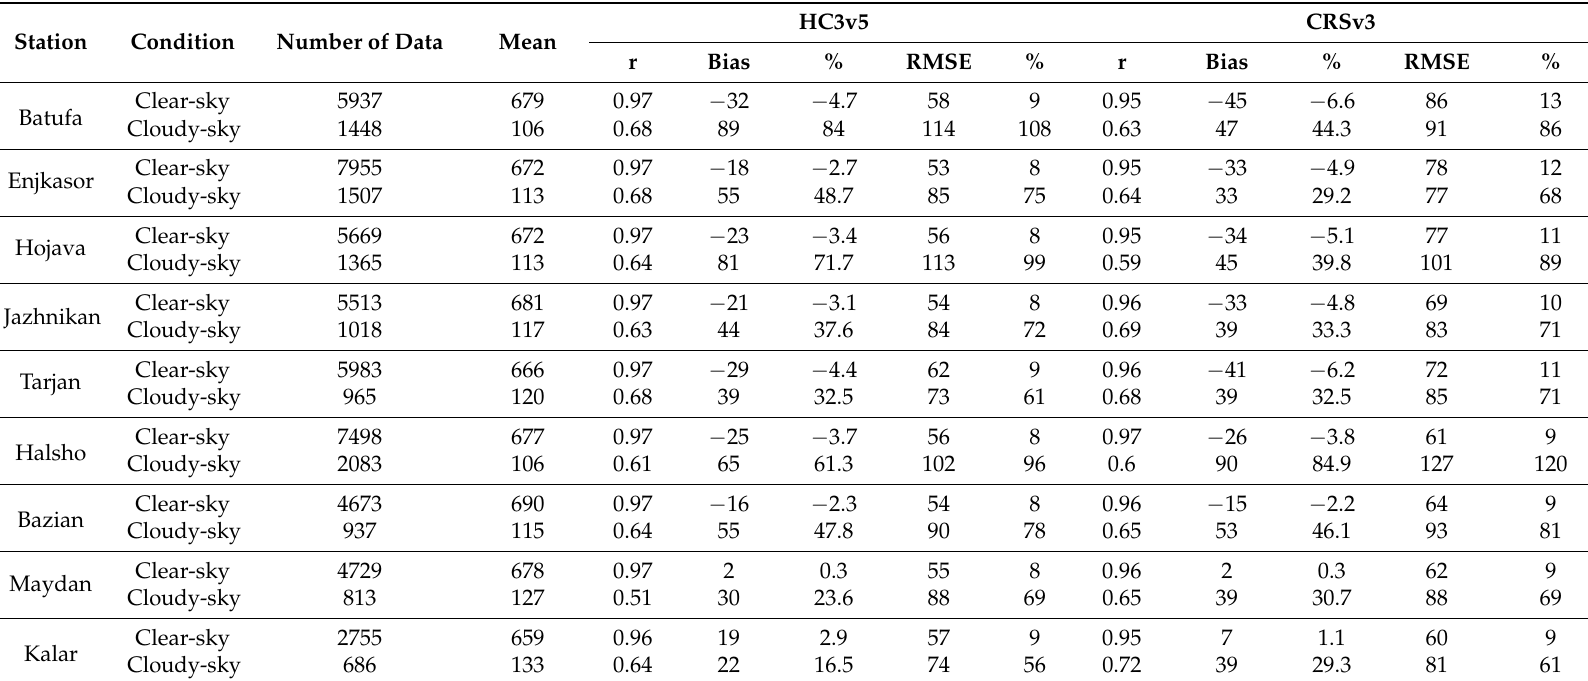
Table 5. Validation of hourly GHI under clear-sky and cloudy-sky conditions. Mean, bias and RMSE units are W/m 2 .